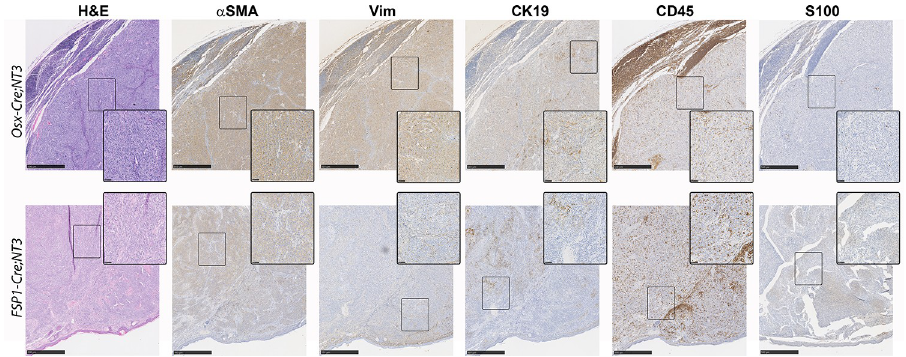
Fig 3. NT3 tumors have features of soft tissue sarcomas. Immunohistochemical staining of representative Osx-Cre; NT3 (top) and FSP1-Cre;NT3 (bottom) tumors for hematoxylin and eosin (H&E), alpha-smooth muscle actin ( α SMA), vimentin (Vim), Cytokeratin 19 (CK19), CD45, and S100 protein. Scale bars = 500 μ M. Insets are taken from boxed regions, with scale bars = 50 μ